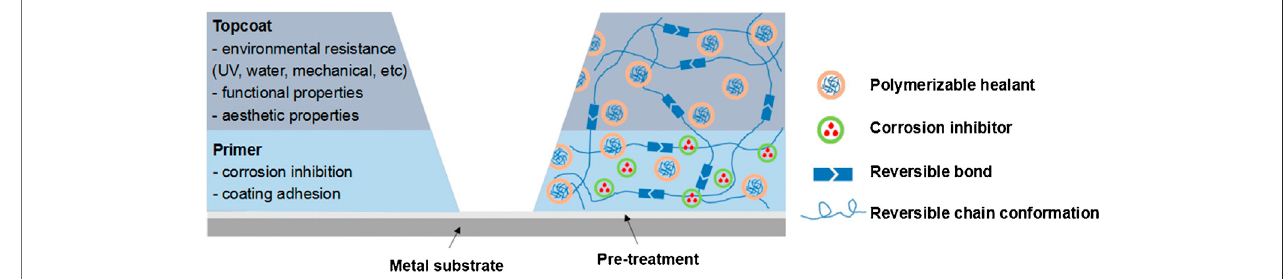
FIGURE 1 | Basic structure and functions of a coating system and major self-healing mechanisms (Zhang et al., 2018).